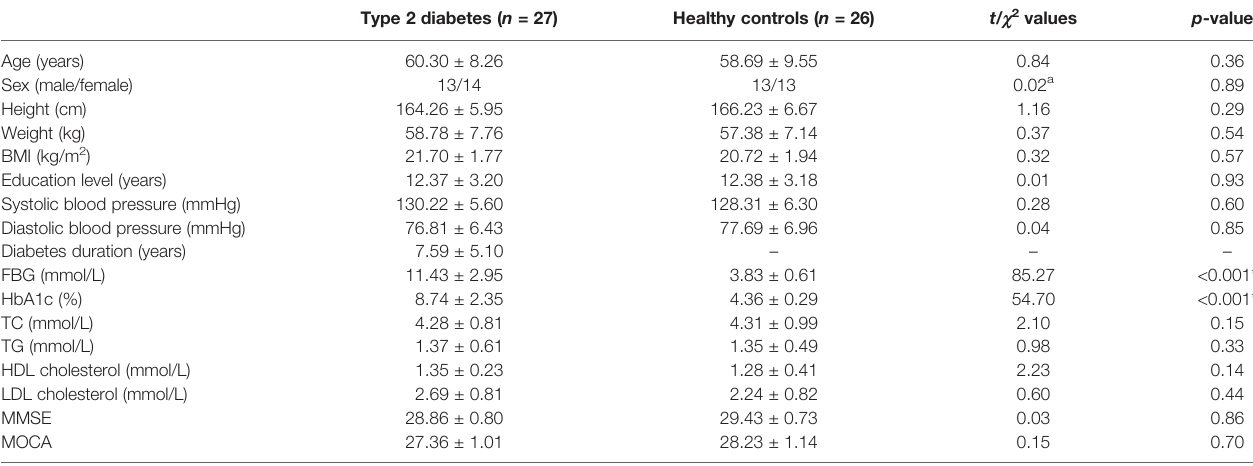
TABLE 1 | Summary of the demographic and clinical data.